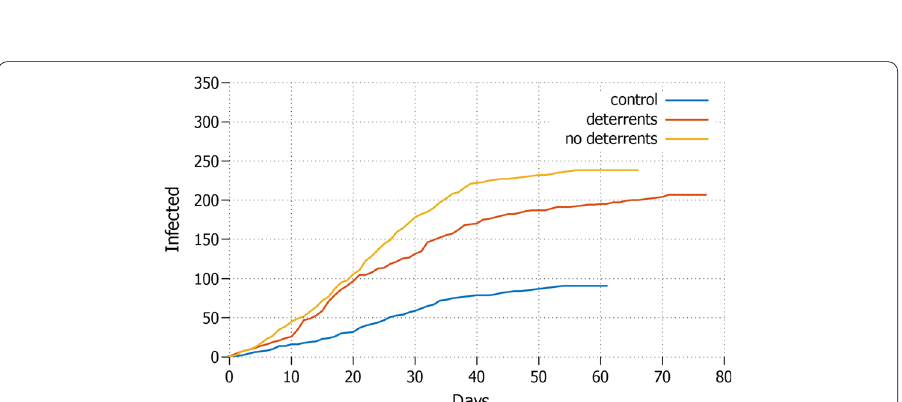
Fig. 8 Essential activities Daily increment with only essential workers allowed to move and protective measures